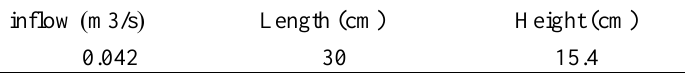
Table1. Specifications of side weir [22]